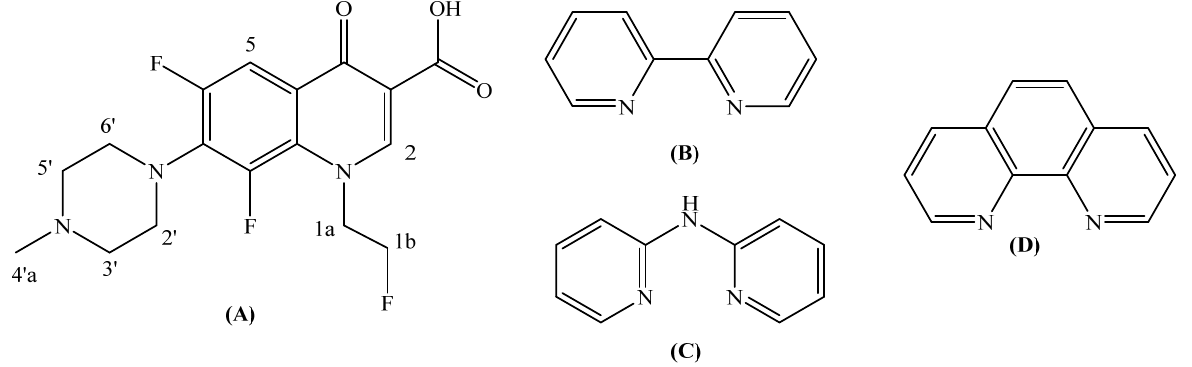
Figure 1. ( A ) The syntax formula and H-atom numbering of fleroxacin (Hflrx). ( B – D ) The N,N ′ - donors used as co-ligands: ( B ) 2,2 ′ -bipyridine (bipy). ( C ) 2,2 ′ -bipyridylamine (bipyam) and ( D ) 1,10- phenanthroline (phen).